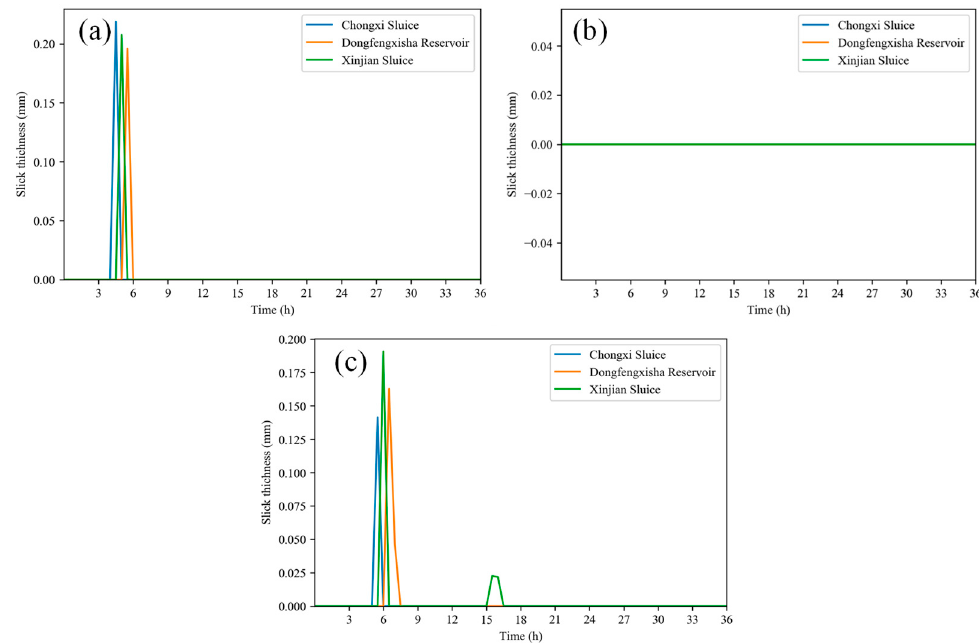
Figure 11. Thickness of oil slick near 3 main sensitive areas in the 36 h after oil spill. ( a – c ) represent slick thickness with time before, during and after typhoon, respectively.